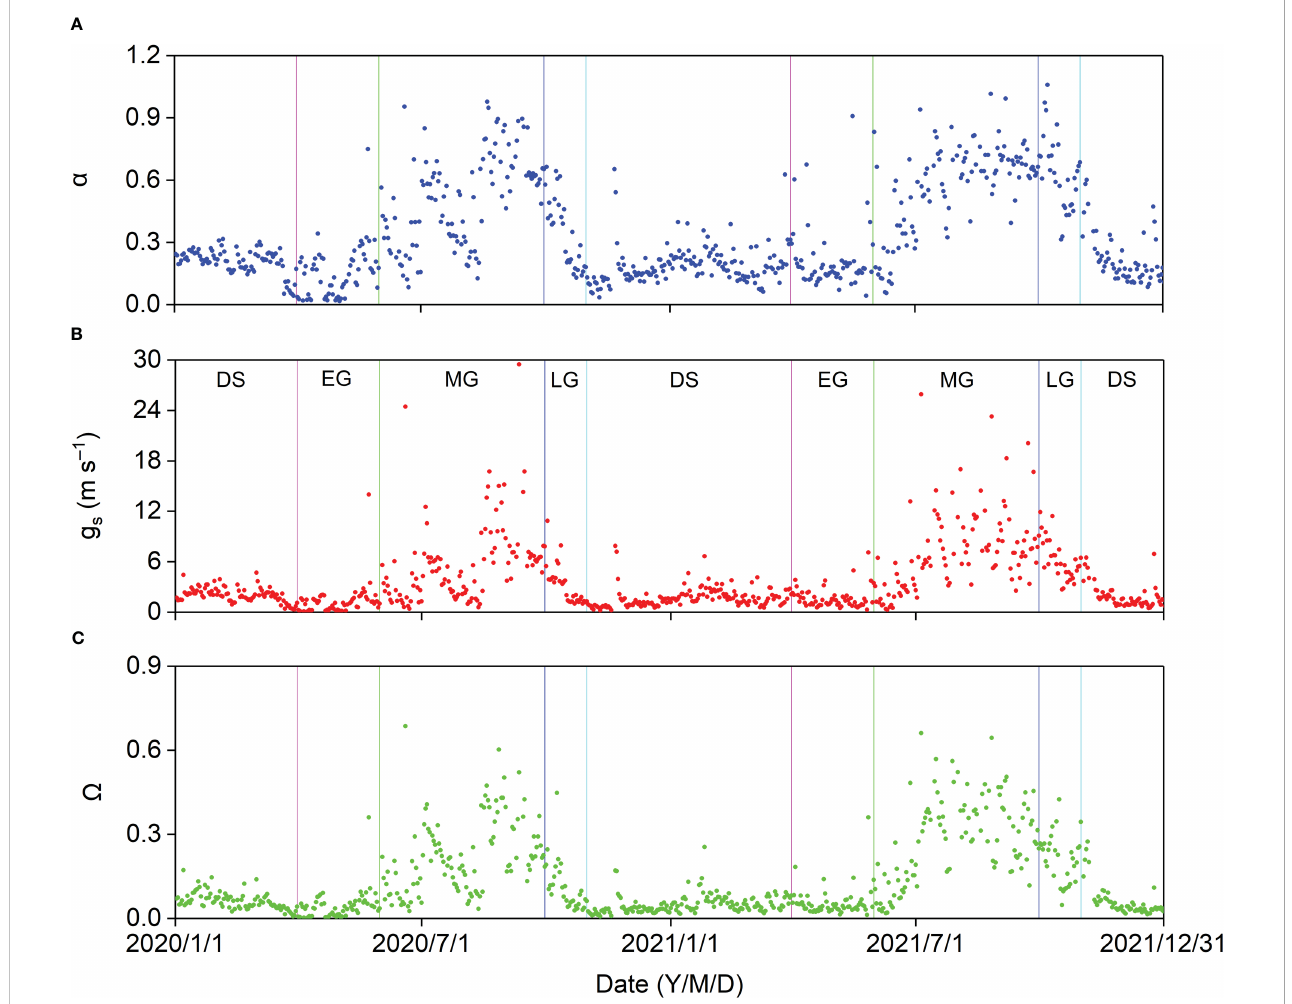
FIGURE 11 Seasonal variation in midday (A) Priestley – Taylor coef fi cient ( a ), (B) surface conductance (g s ), and (C) decoupling coef fi cient ( W ) in 2020 and